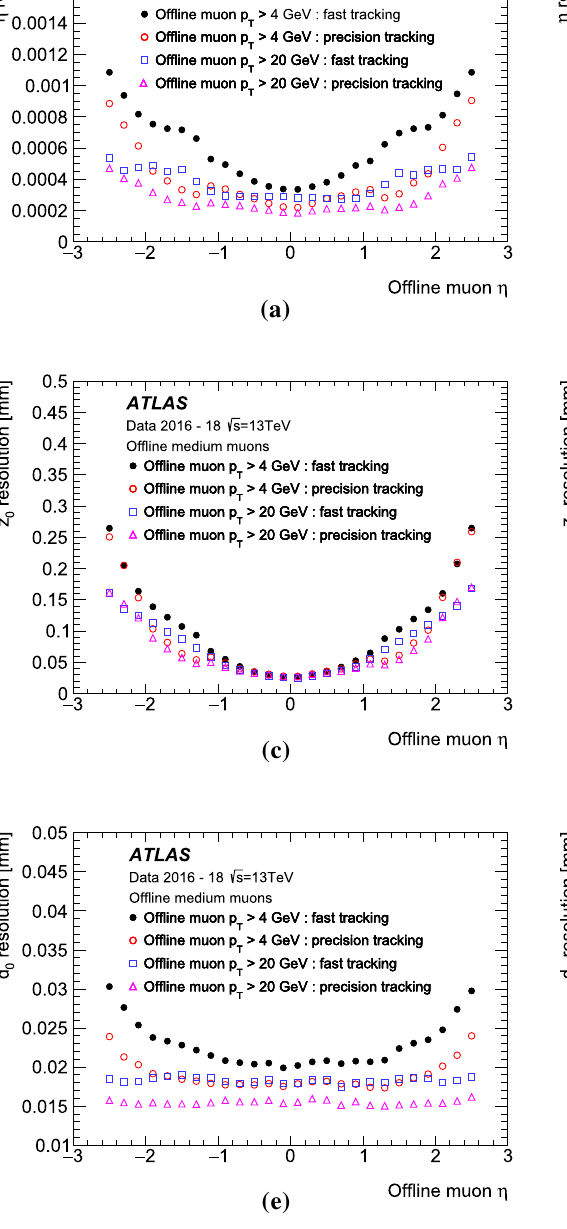
Fig. 18 The track resolution for pseudorapidity ( η ), track z -vertex position, and transverse impact parameter with respect to the beam line, d 0 , as a function of offline track pseudorapidity and transverse momen-